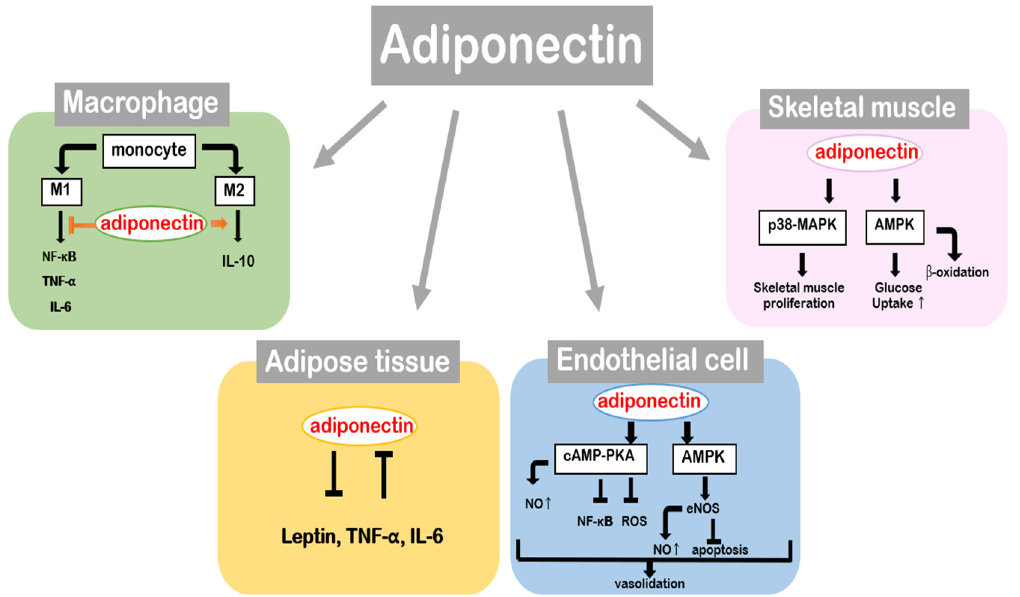
Figure 4. Physiological roles of adiponectin in the main tissues.